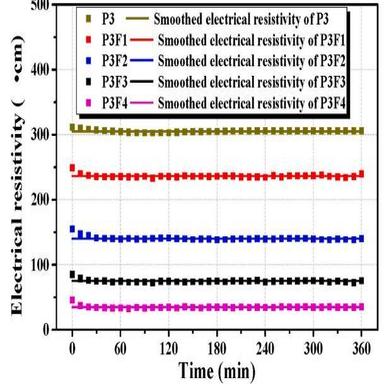
Electrical resistivity of saturated steel fiber paste specimens.